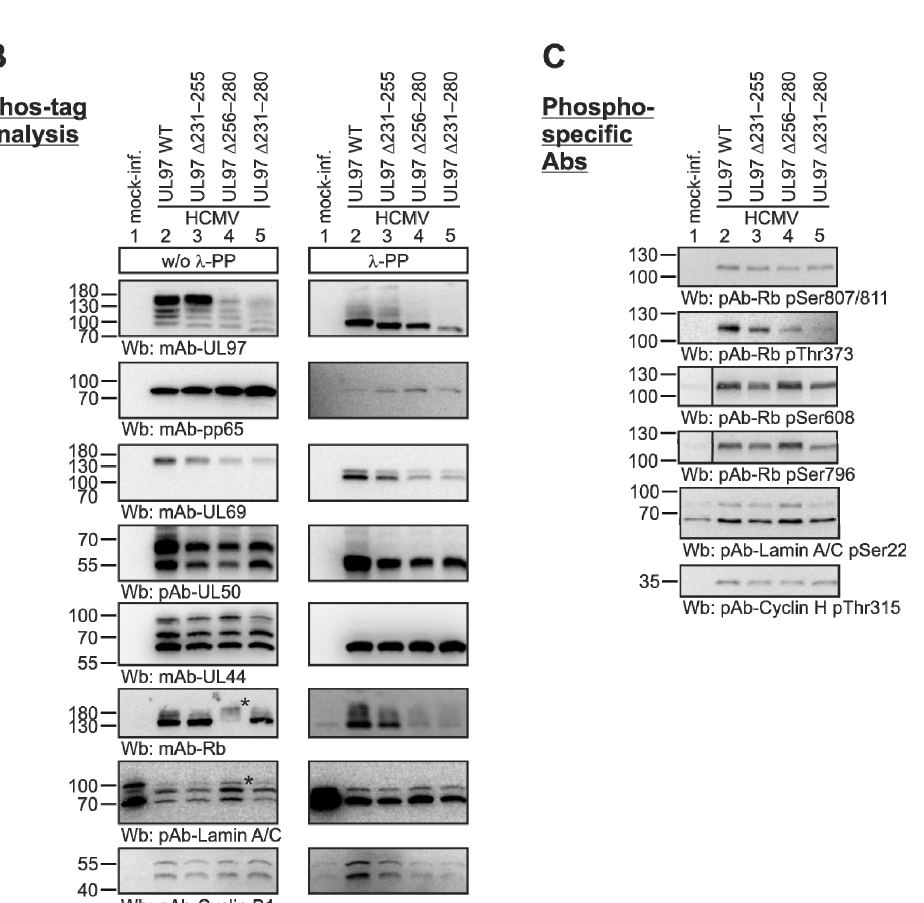
Figure 4. Measurement of viral pUL97-specific kinase activities, using ( A ) in vitro kinase assay, ( B ) Phos-tag analysis and ( C ) phosphorylation-specific antibodies. HFFs were infected with HCMV WT or UL97 mutant versions at an MOI of 1. At 4 d.p.i. (WT) or the time point referring to approximately 80% of virus-induced CPE (mutants), cells were lysed and kinase activity of pUL97 was analyzed by in vitro kinase assay (IVKA) ( A ). pUL97 was immunoprecipitated together with pUL69 using specific antibodies (Abs). Lysate control was taken prior to CoIP. CoIP-enriched proteins were sub- jected to an IVKA reaction utilizing ATP γ S, which is used by kinases to thiophosphorylate sub- strates. Subsequent alkylation of thio-phosphorylated substrates with p-nitrobenzyl mesylate yields thiophosphate esters (TPE), which were detected via specific Abs on Western blot (Wb). To confirm phosphorylated proteins, Wbs were restained using protein-specific Abs. Alternatively, phosphor- ylation pattern of relevant pUL97 substrates was analyzed via Phos-tag SDS-PAGE ( B ) or phospho- specific Abs ( C ). For details of the methodological procedures of the use of Phos-tag and phospho- specific Abs, see Section 2.4. *, Note the occurrence of an unusual phospho-specific band for Rb and a so far unexplained upregulation effect for nuclear lamin A/C, respectively.